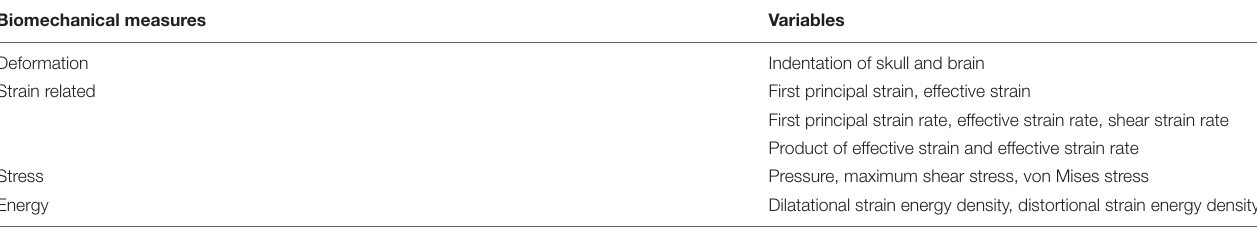
TABLE 1 | Biomechanical variables used to compare with clinical data.